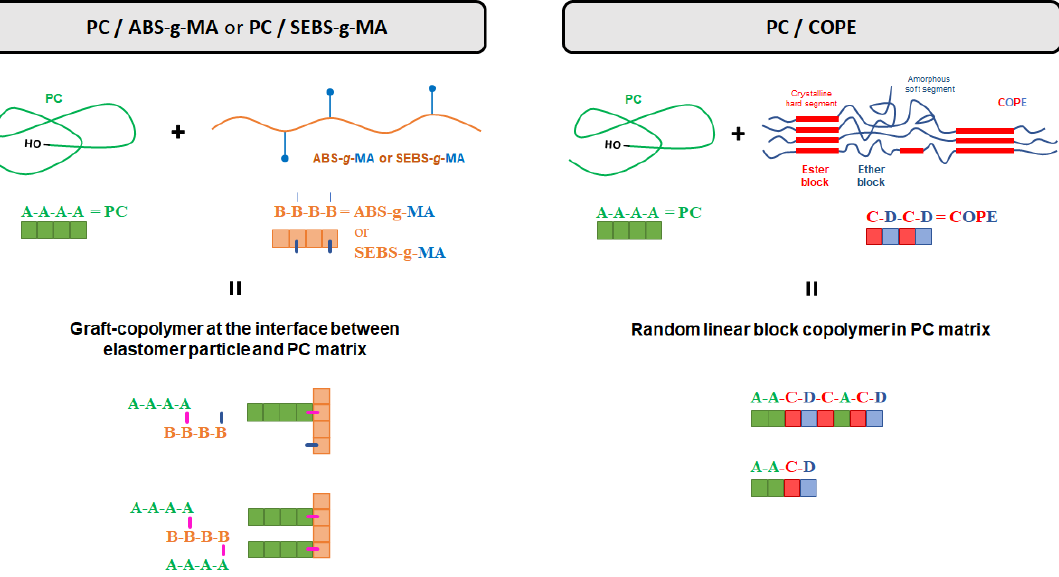
Figure 3. Copolymer structure and dispersion on PC matrix as a result of the reaction between PC/ABS- g -MA or PC/SEBS- g -MA ( left ) and PC/COPE ( right ).